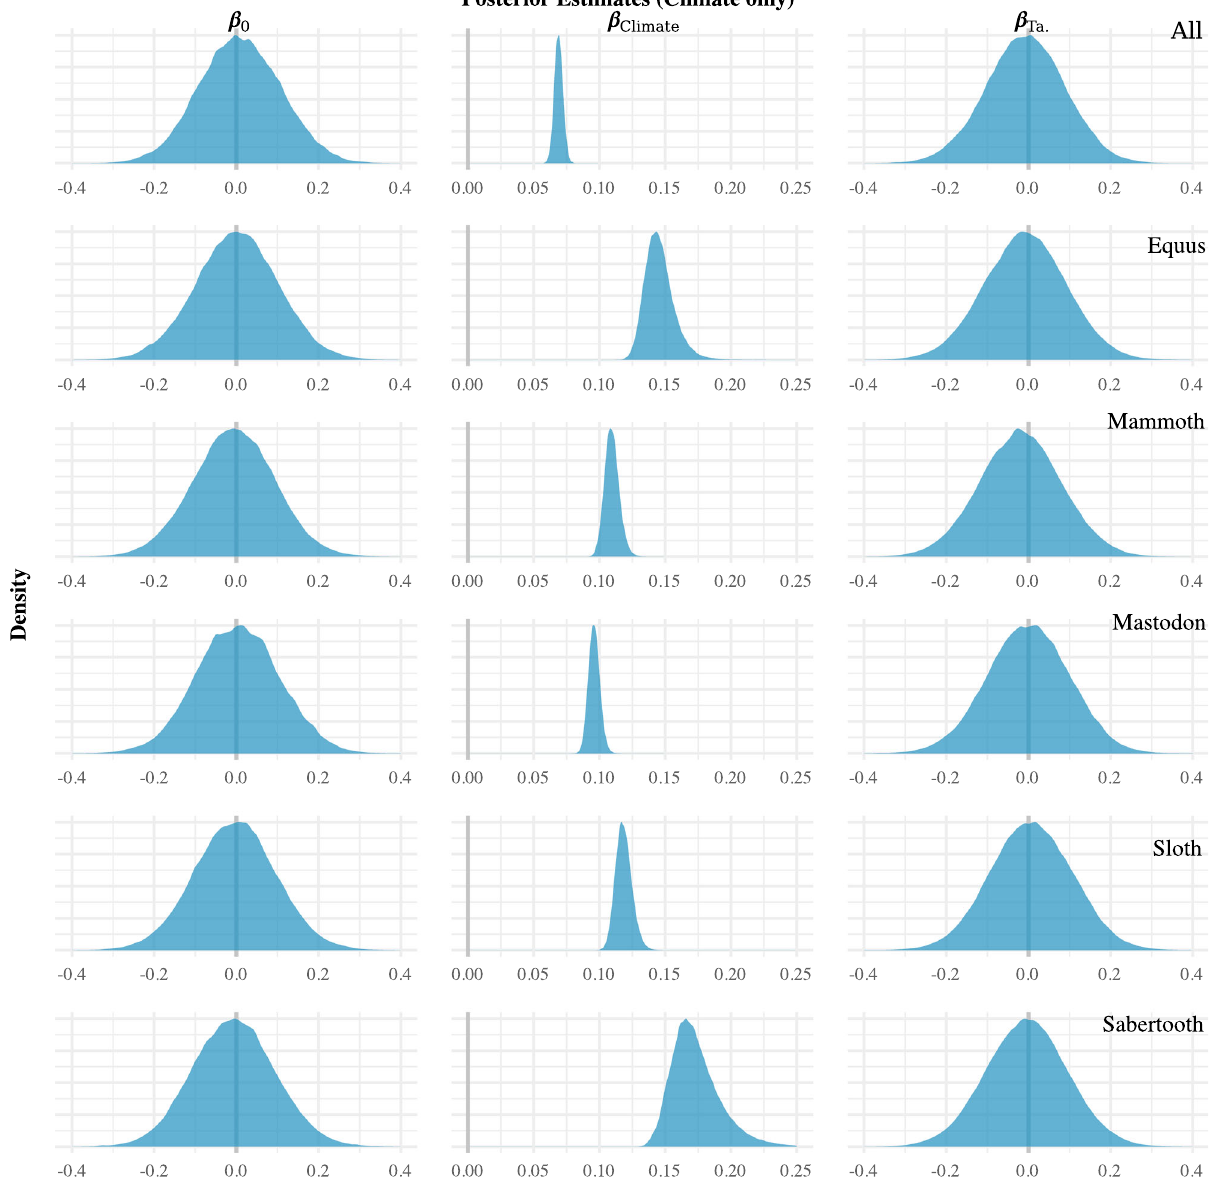
Fig. 3 Regression results for the climate only models. Note that the estimates for the climate model parameter ( β Climate ) do not overlap zero (denoted by vertical the grey